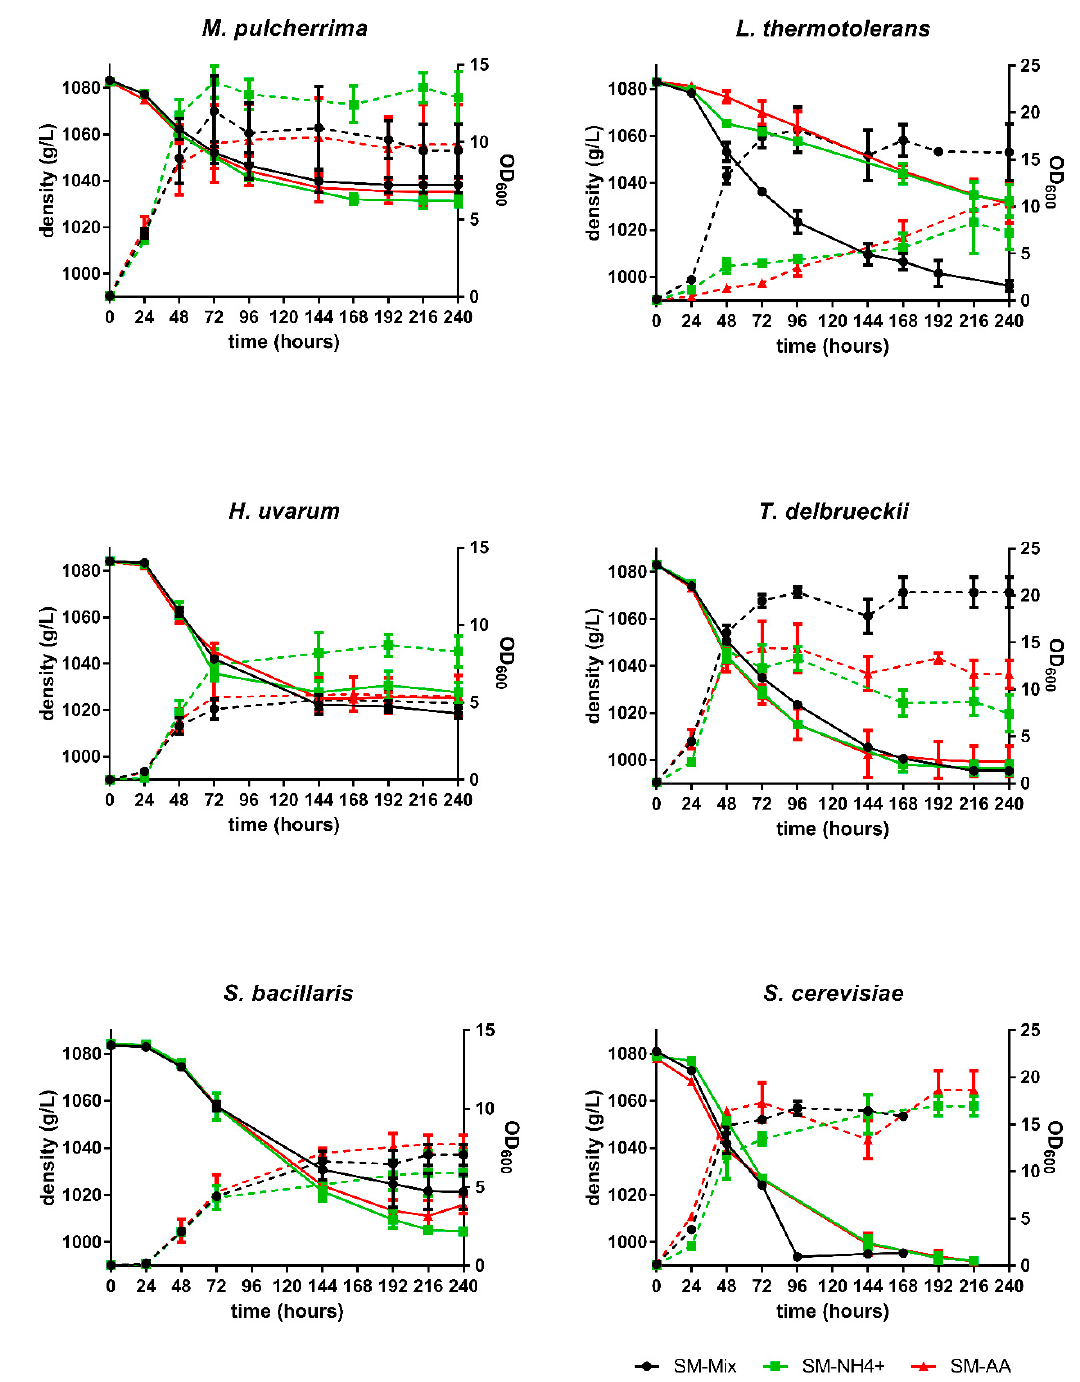
Figure 1. Fermentation kinetics and yeast growth of each species in synthetic must with di ff erent nitrogen sources: inorganic nitrogen only (SM-NH 4 + ), organic nitrogen only (SM-AA), and a mixture of organic and inorganic nitrogen (SM-Mix). Solid lines refer to density and dotted lines refer to OD 600 . Error bars represent standard deviation.